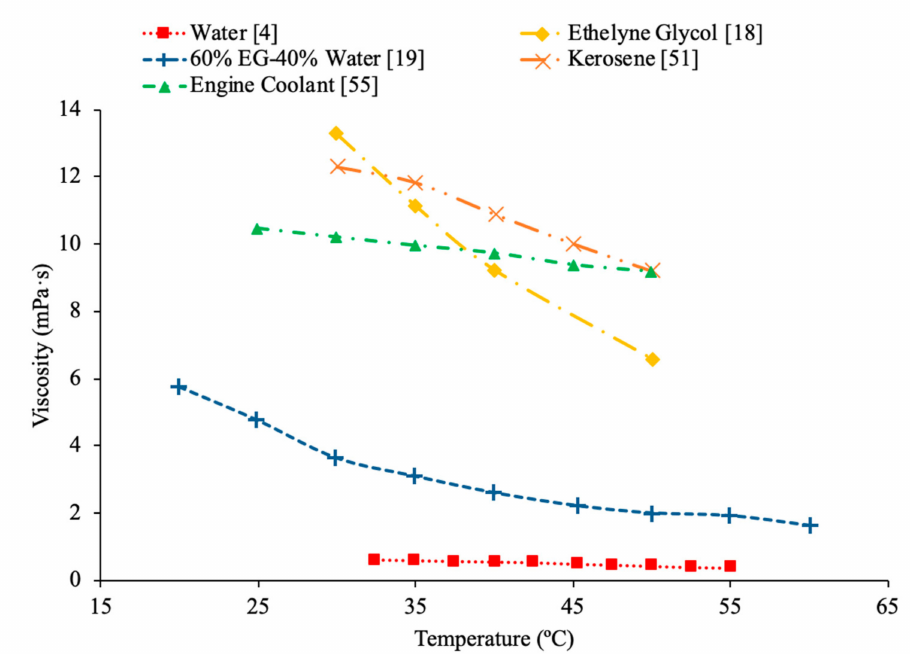
Figure 22. Comparison of viscosity of various base fluids as a function of temperature